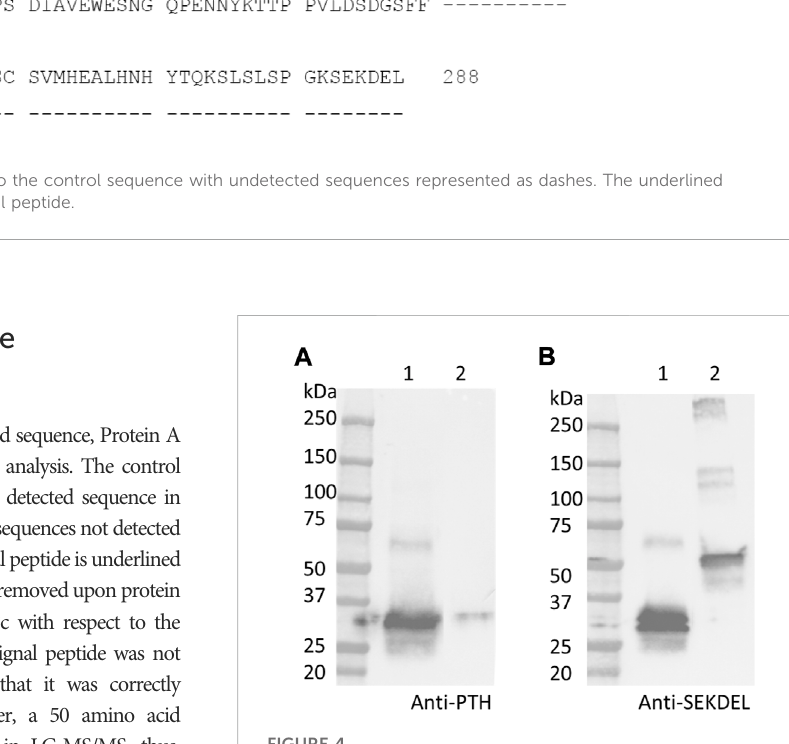
FIGURE 4 WesternblotanalysesdetectingPTH (A) andSEKDEL (B) sequences for puri fi ed PTH-Fc (lane 1) and a control protein (lane 2, 47.2 kDa) with theSEKDELC-terminalmotif.Fromlefttoright:molecularweightladder, PTH-Fc and a control protein with SEKDEL C-terminal